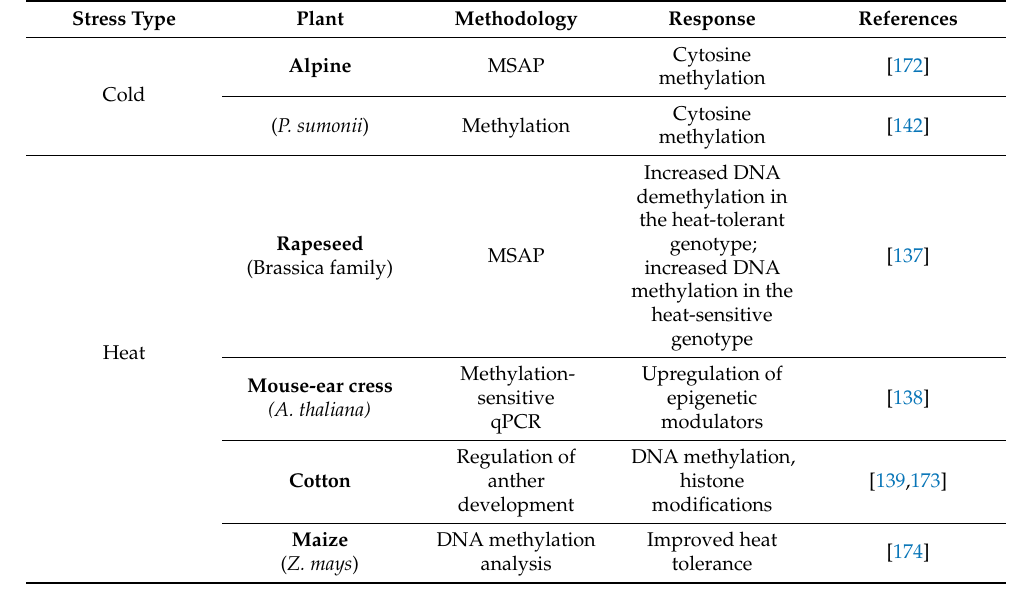
Table 2. Recent studies on DNA methylation in diverse plant species under heat and cold